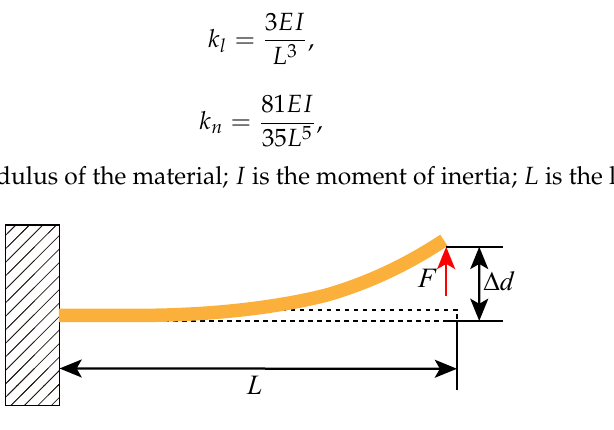
Figure 5. Mechanical analysis of the single clamped cantilever